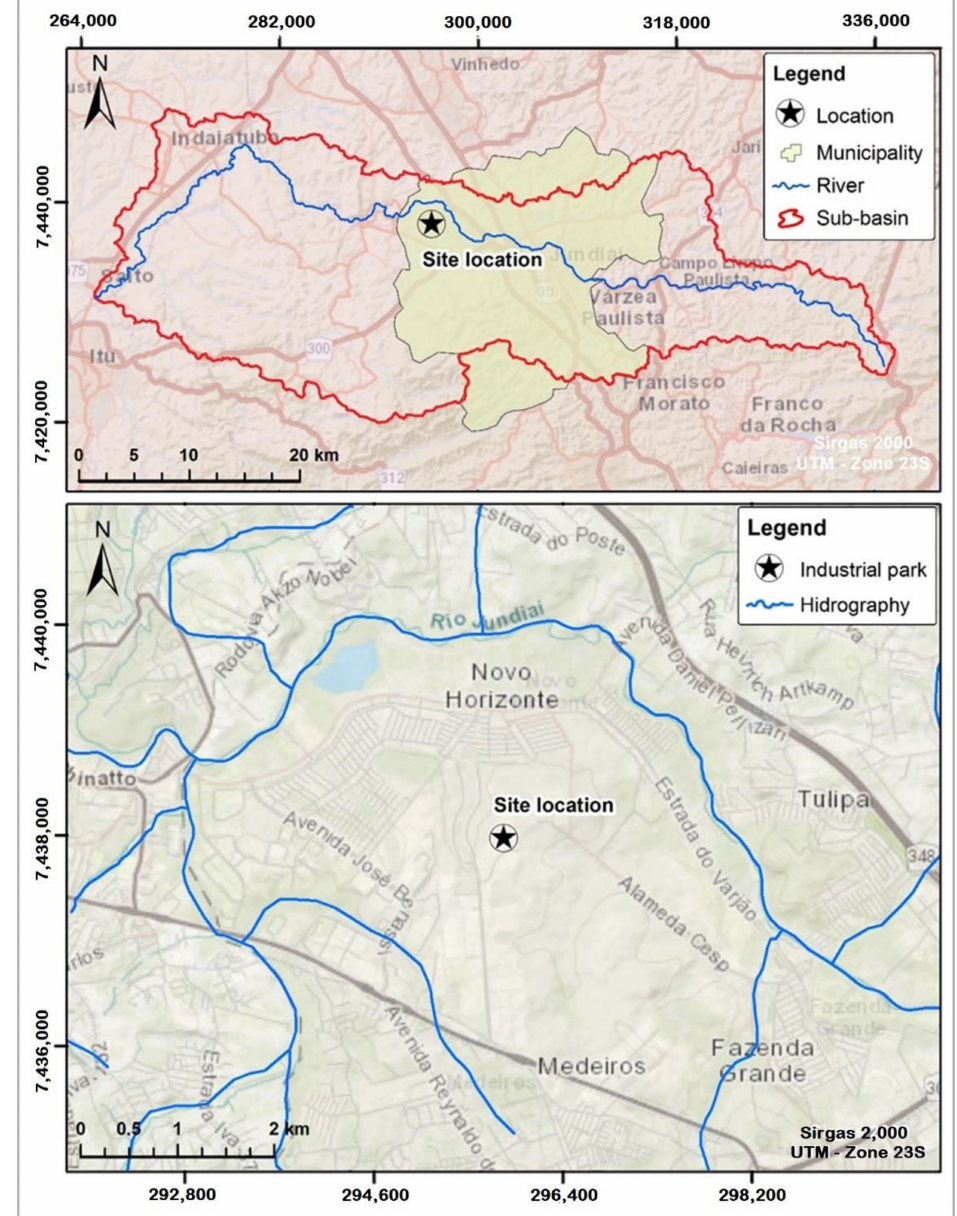
Figure 2. Site location in the watershed–SP and industrial park region, with the main local water- courses and roads. (Data source: